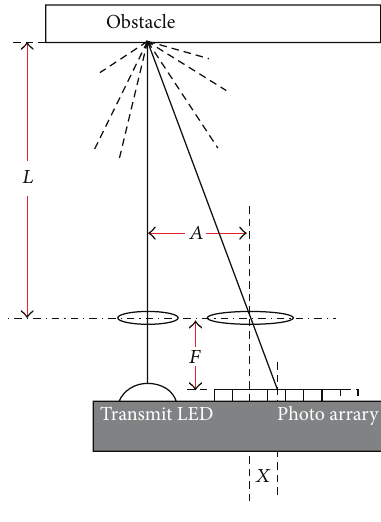
Figure 5: Distance